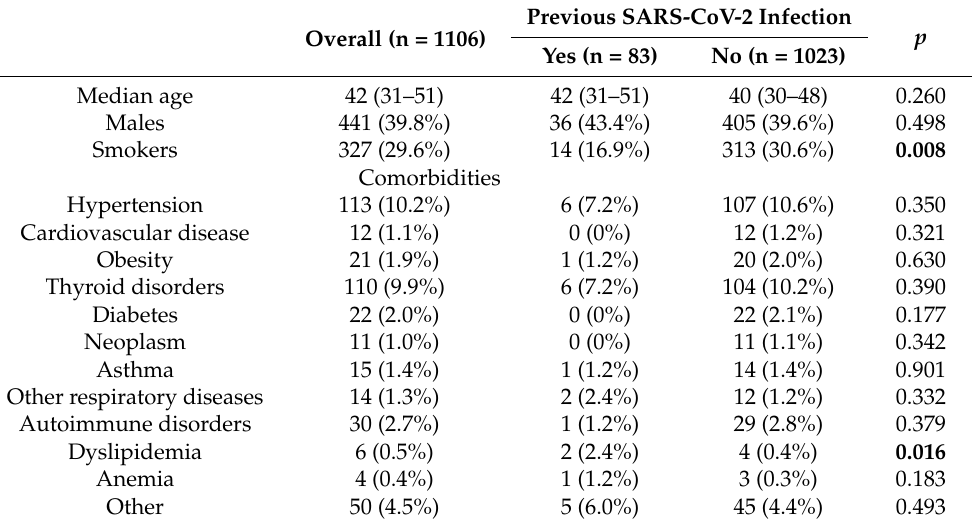
Table 1. Baseline characteristics of the study population, overall and stratified according to prior SARS-CoV-2 infection.